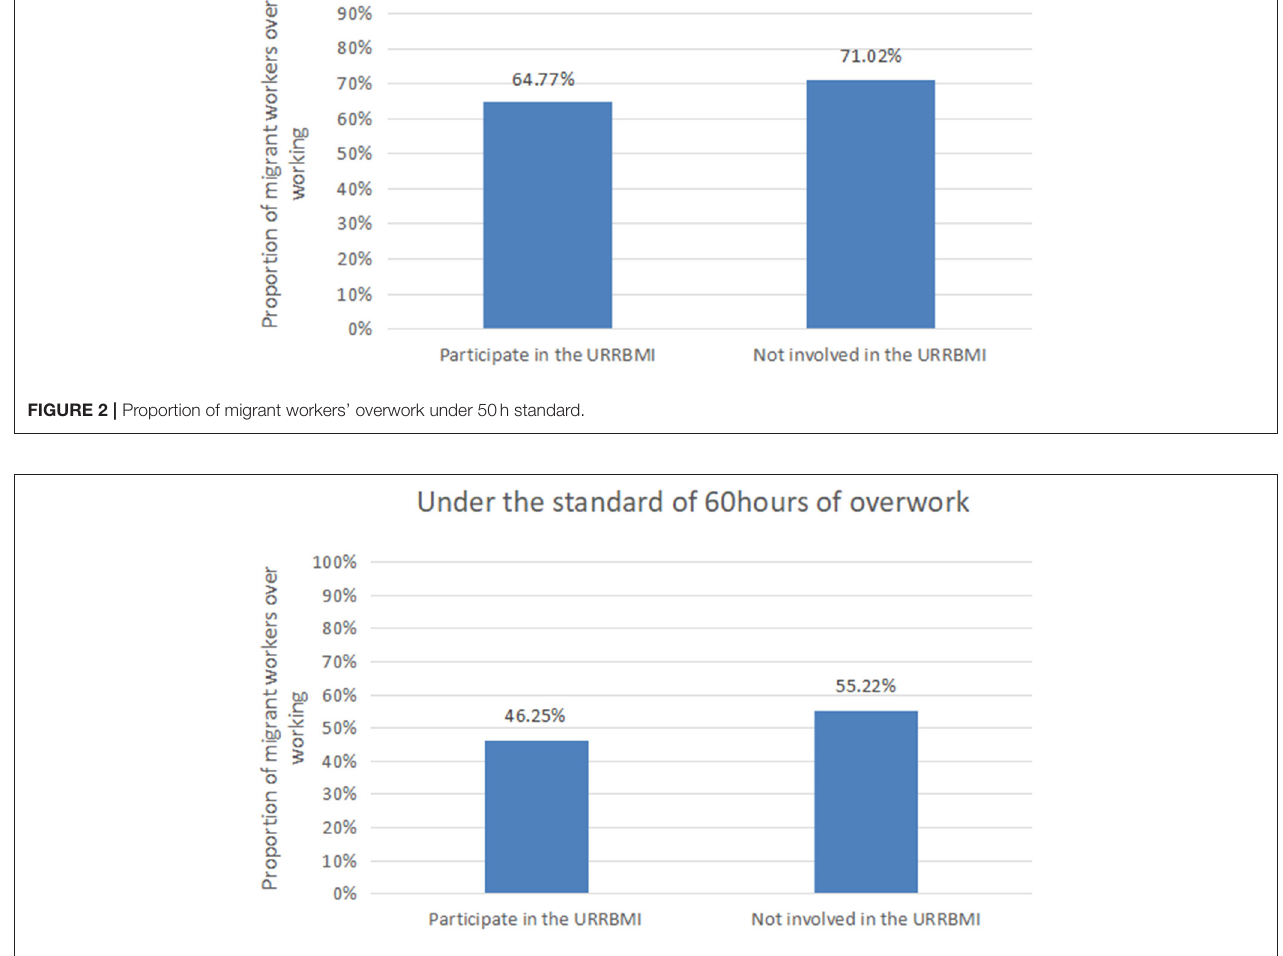
FIGURE 3 | Proportion of migrant workers’ overwork under 60h